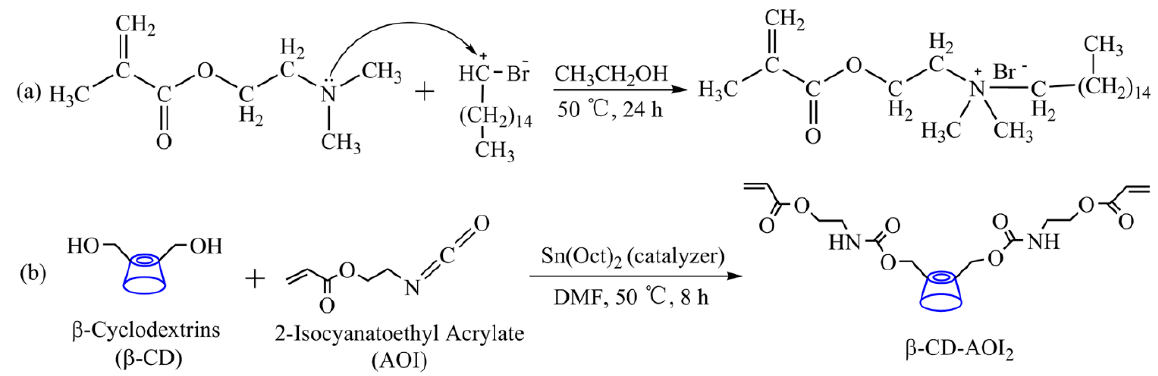
Figure 1. Synthesis of ( a ) DMB and ( b ) β -CD-AOI 2 .